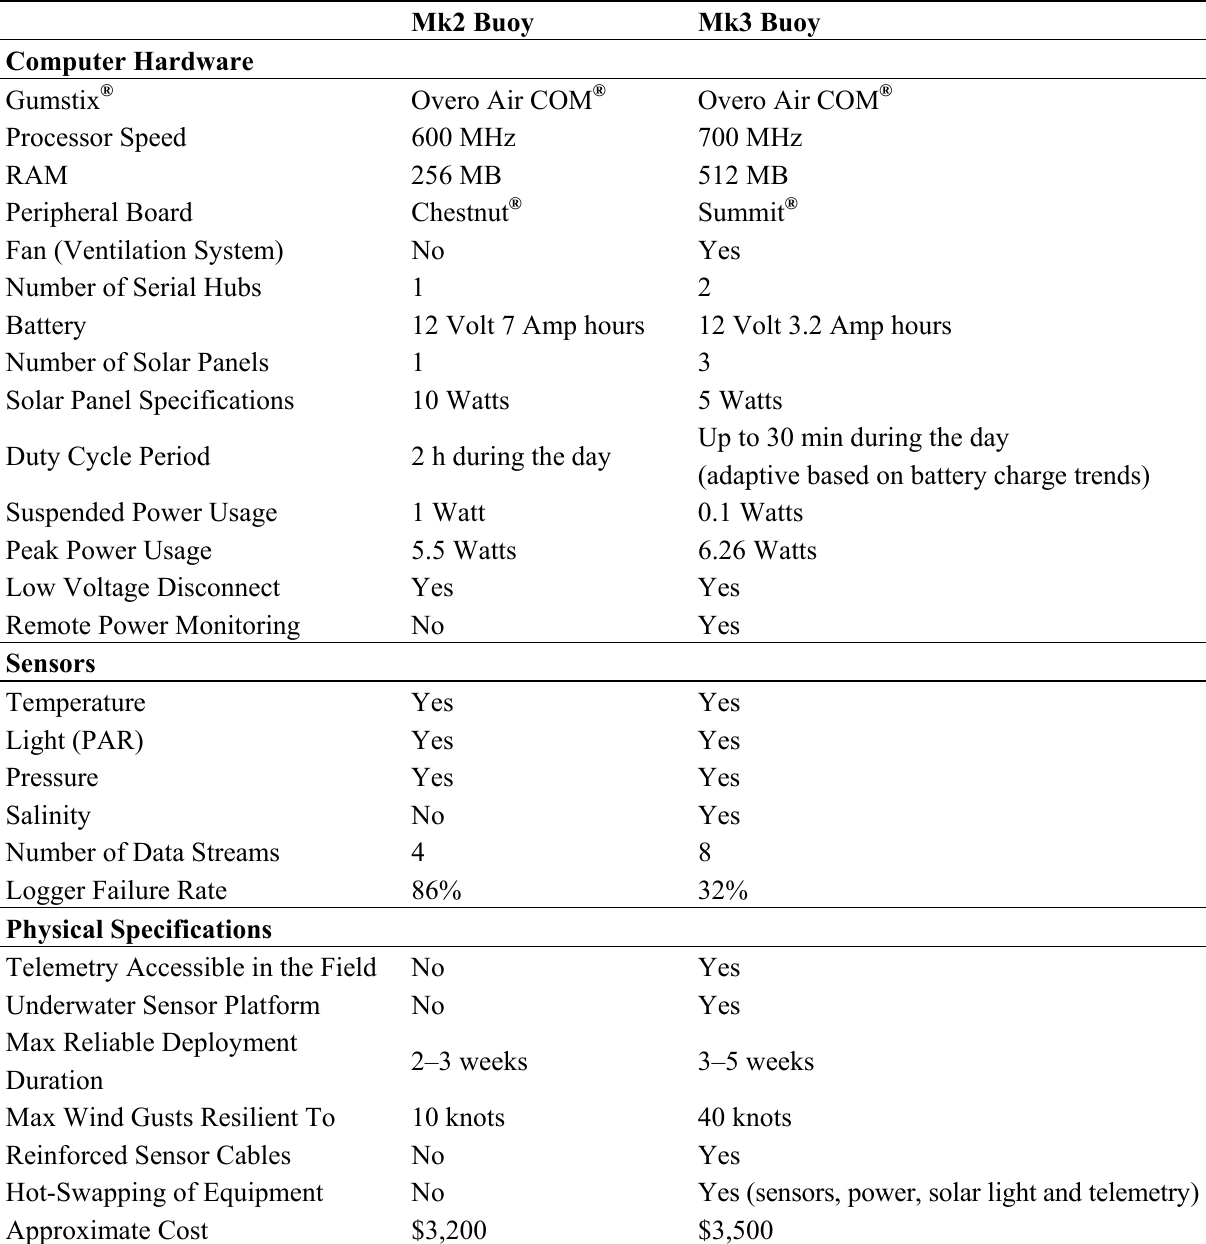
Table 1. Technical specifications for the Mk2 and Mk3 SEMAT